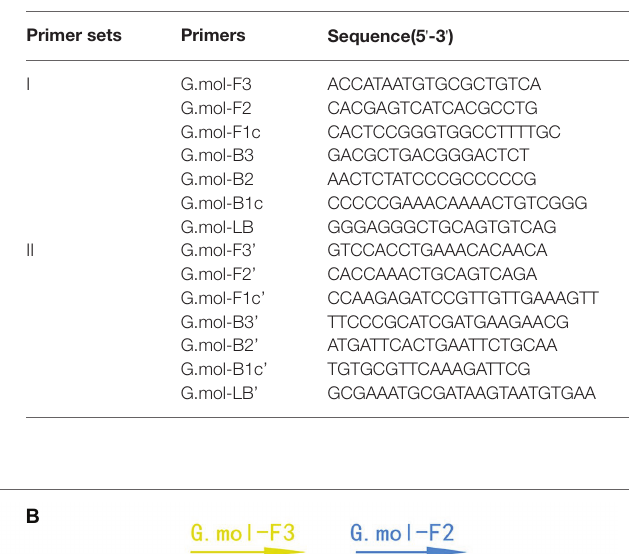
TABLE 2 | Primer sets for Gyromitra infula LAMP